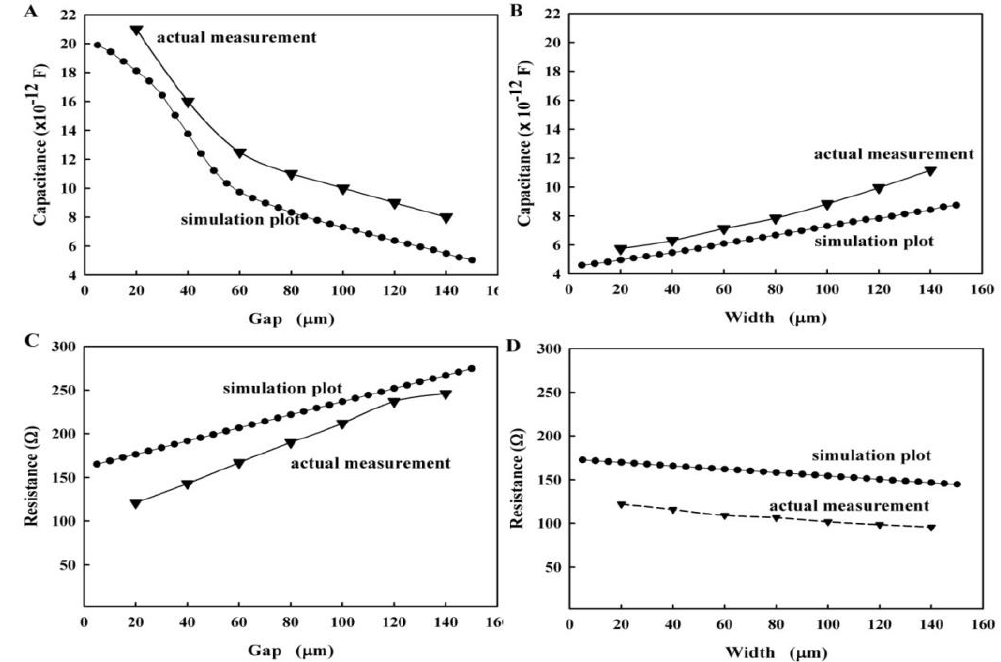
Figure 4. Influence of the geometric parameters of the electrode on the equivalent circuit. ( A ) The influence of the electrode gap on the equivalent capacitance; ( B ) Influence of the electrode band width on the equivalent capacitance; ( C ) Influence of the microelectrode gap on the equivalent resistance; ( D ) Influence of the microelectrode width on the equivalent resistance.